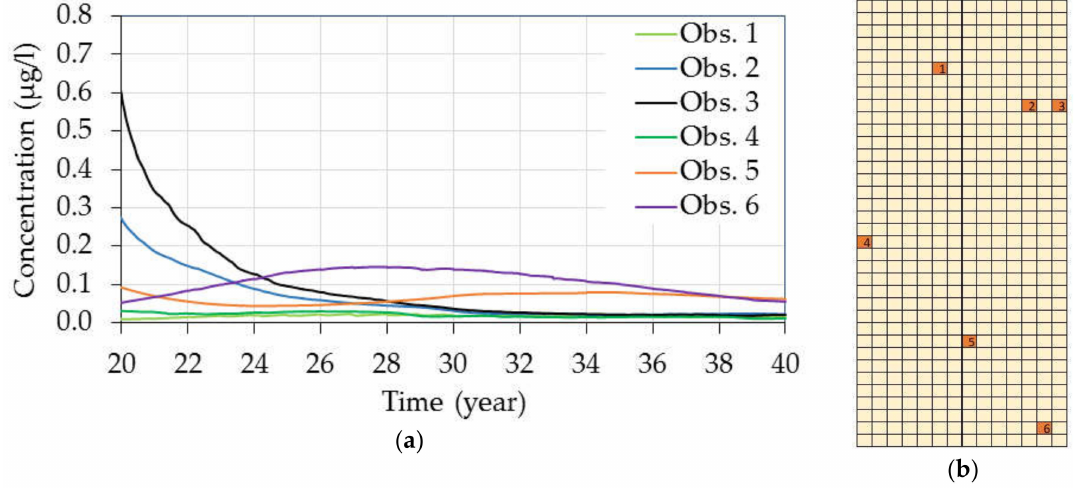
Figure 14. Atrazine concentrations in six observation wells after 20 years of atrazine application ( a ), and the locations of the observation wells ( b